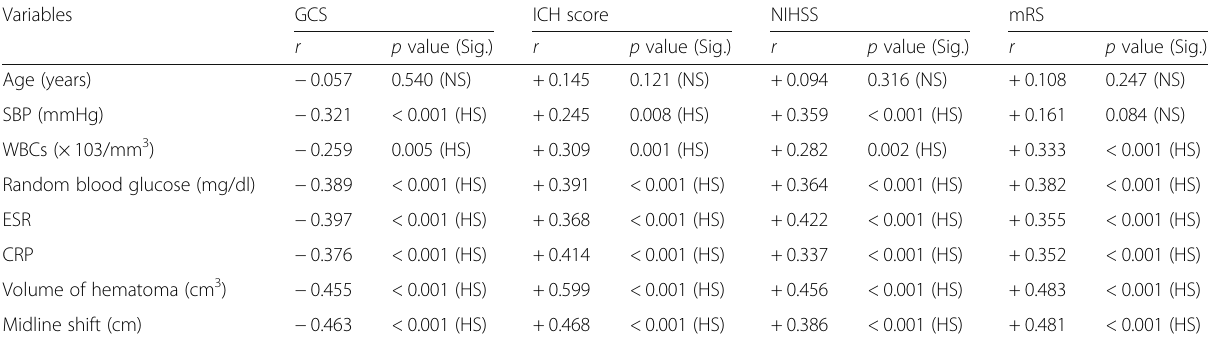
Table 3 Correlation between Glasgow Coma Score, Intracerebral Hemorrhage Score, National Institute of Health Stroke Score, Modified Rankin Score, and selected study parameters Variables